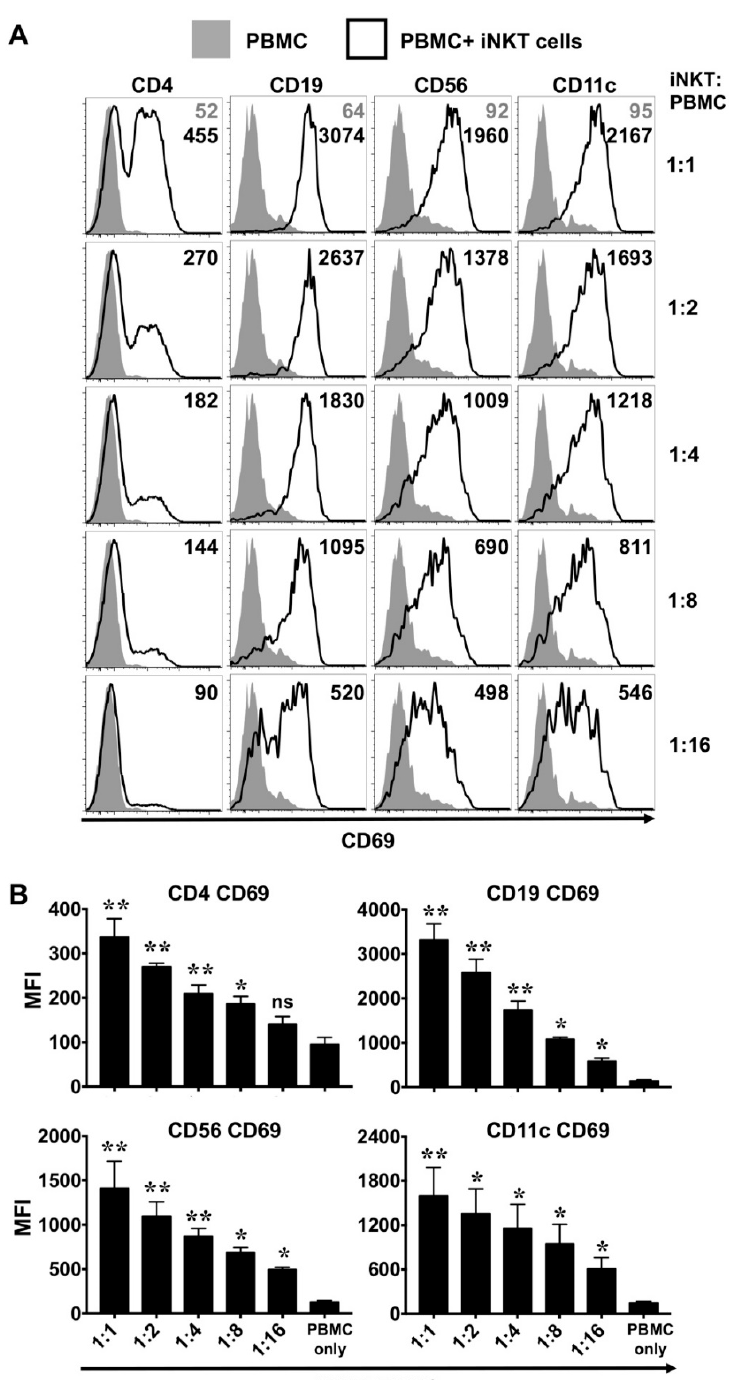
Figure 5. NKTT320-stimulated human iNKTs trans-activate bystander immune cells in vitro. ( A , B ) Freshly isolated human iNKTs were mixed with autologous PBMCs at different ratios as indicated. Control wells had PBMCs only. Cells were added to plate-bound NKTT320 mAb (1.0 µ g / mL). After 24 h, cells were harvested and analyzed for CD69 by flow cytometry on different immune cells as indicated. Representative histograms from one of at least four independent experiments are shown in ( A ). Numbers in the histograms indicate MFI. ( B ) Pooled data (mean ± SEM) from 4 independent experiments showing MFI for CD69 expression on various immune cells, as indicated on the graphs. Statistical significance was determined using one-way ANOVA. For each of the analysis, all the groups were compared to control wells (PBMC only). * p < 0.05, ** p < 0.01, ns: not